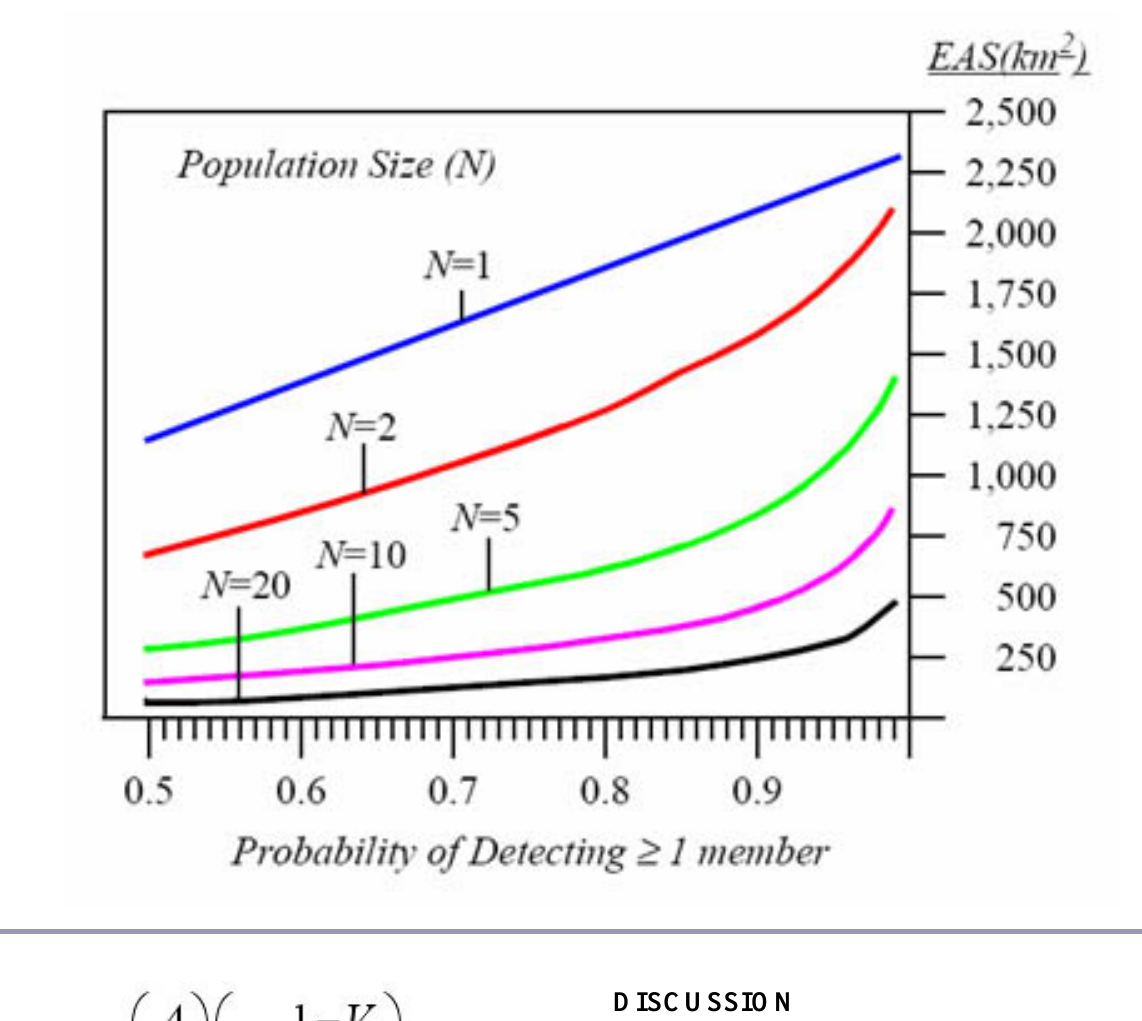
Fig. 3. The area that must be effectively surveyed (EAS) relative to the probability of detection of at least one member of a randomly distributed population of Ivory-billed Woodpeckers across a 233 896- ha study area for actual populations of different